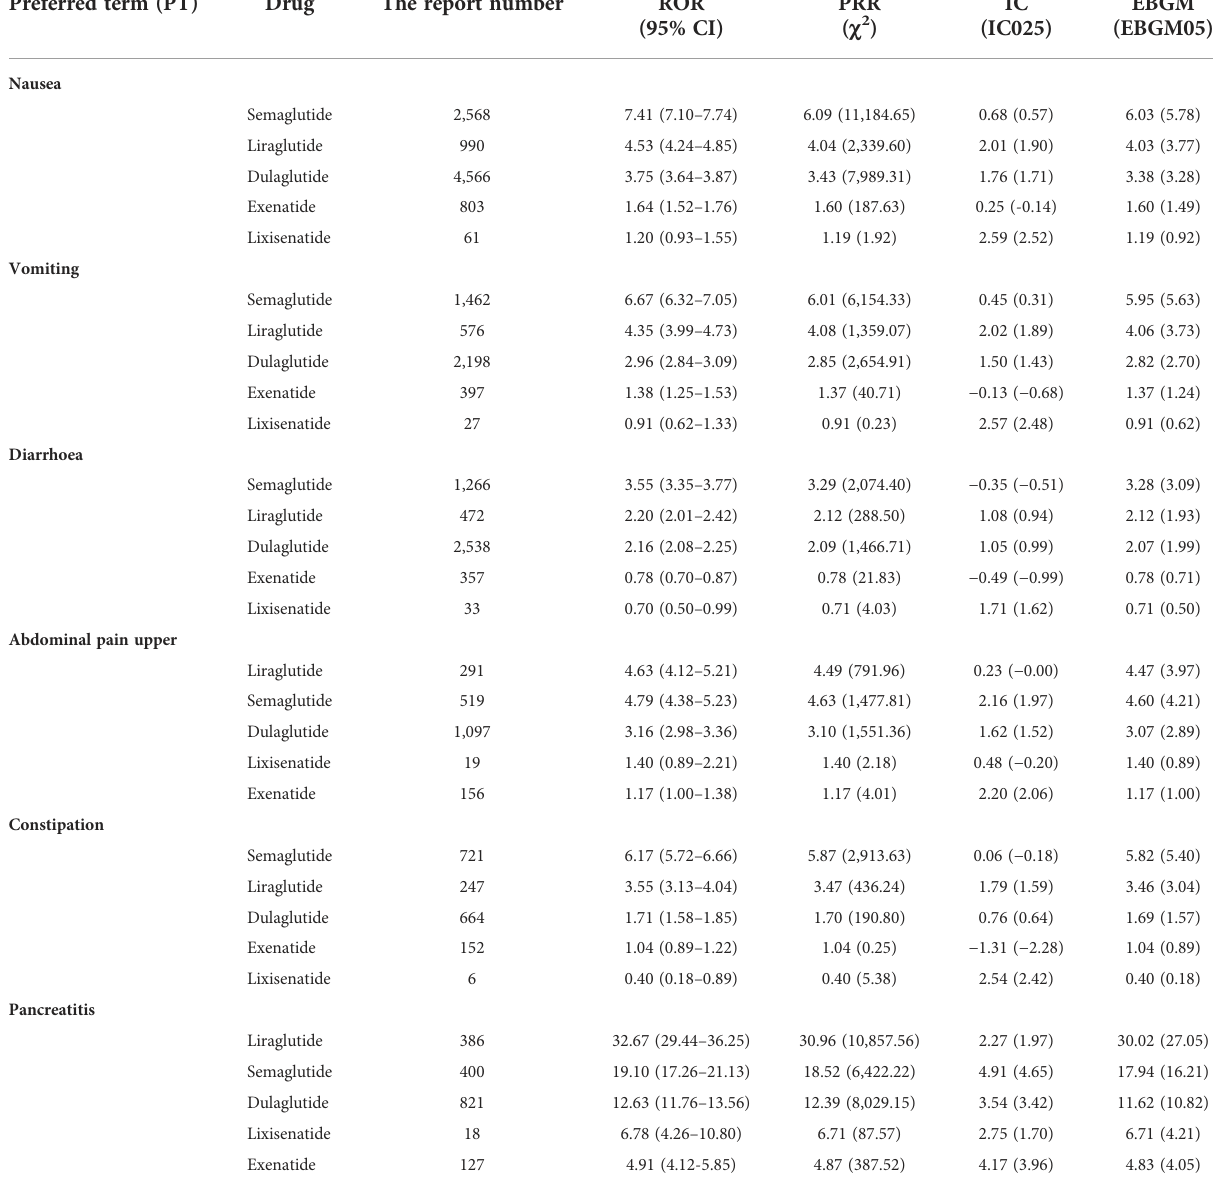
TABLE 3 The difference of signal strength in the top six most frequently reported gastrointestinal adverse events among different GLP-1 RAs.